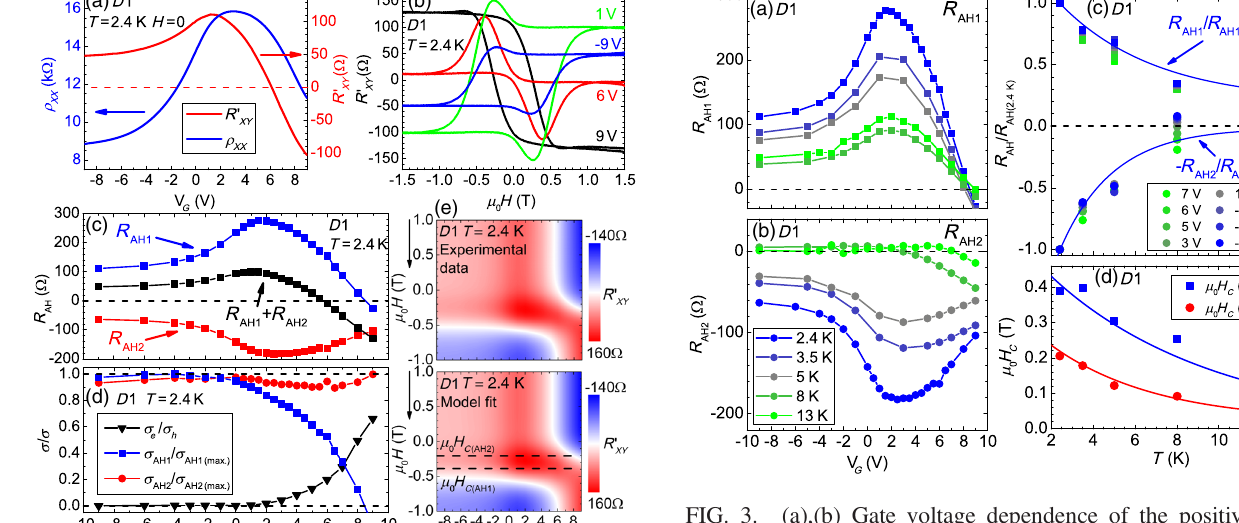
FIG. 3. (a),(b) Gate voltage dependence of the positive and negative contribution for measurements at various temperatures. (c) Temperature dependence of each of the (normalized) compo- nents, and (d) temperature dependence of the coercive field associated with each of the component. (The lines are guides to the